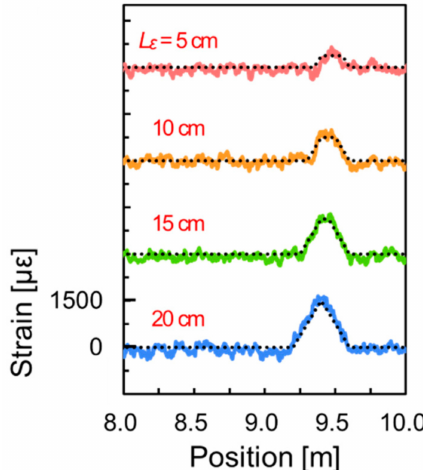
Figure 12. Magnified views of the deduced strain distributions with a spatial resolution of 19.6 cm; a 1500 µε strain was applied to 5-cm- to 20-cm-long sections. Each distribution was shifted by 3000 µε , and the dotted lines indicate the simulated data. Reproduced with permission from [60]. Copyright (2016)